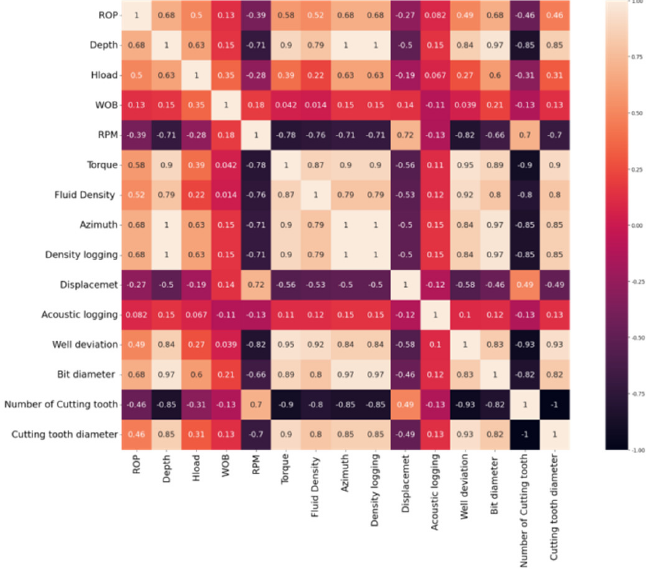
Figure 9. The Pearson correlation coefficient between each parameter.